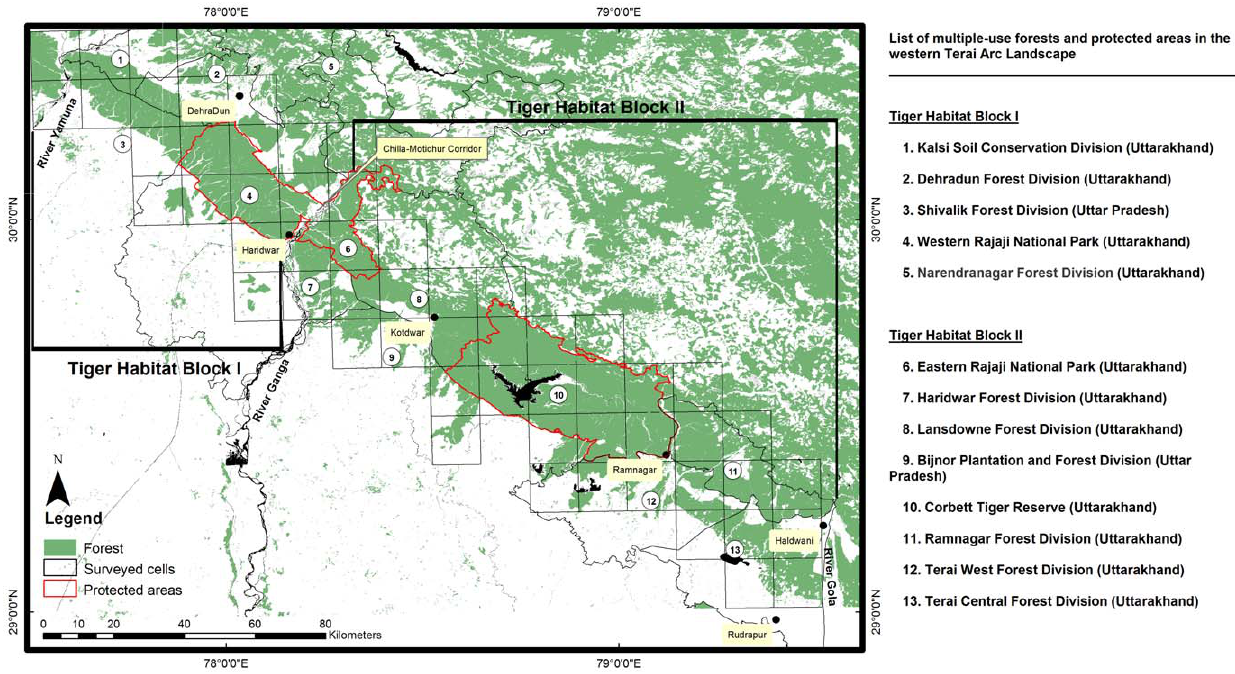
Figure 1. Potential tiger habitat in the western Terai Arc Landscape. Framed within 57 grid cells (166 km 2 ) spanning the area between river Yamuna and river Gola are the two Tiger Habitat Blocks (THB’s). Also indicated are the administrative units highlighting the protected areas of Rajaji National Park (RNP) and Corbett Tiger Reserve (CTR), the Chilla-Motichur corridor along the river Ganga and the major towns/cities in the area.